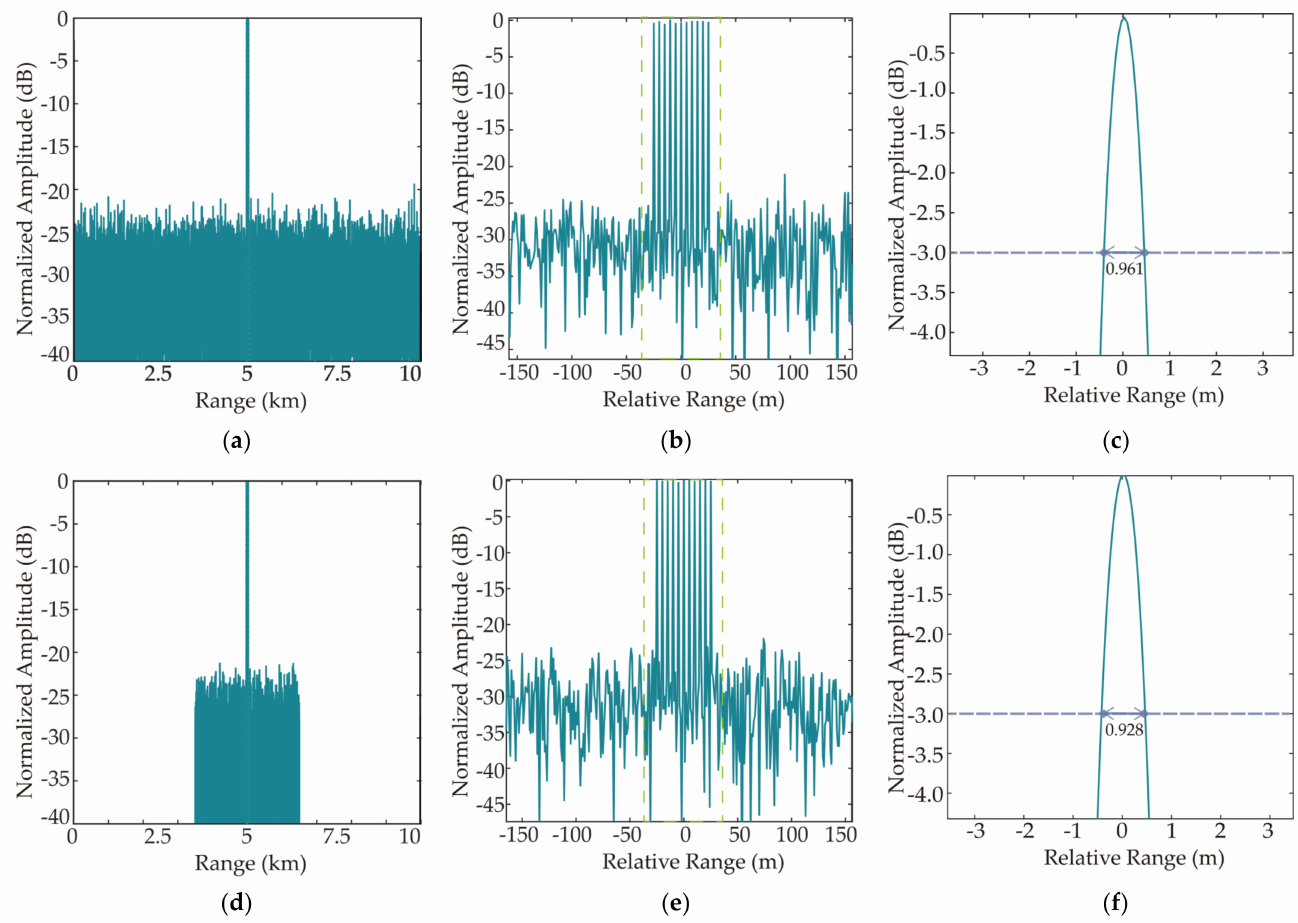
Figure 13. Imaging results in the range direction. ( a ) Result of the current framework; ( b ) enlarged target’s area in ( a ); ( c ) interpolated peak of the center point in ( b ); ( d ) result of the proposed framework; ( e ) enlarged target’s area in ( d ); ( f ) interpolated peak of the center point in ( e